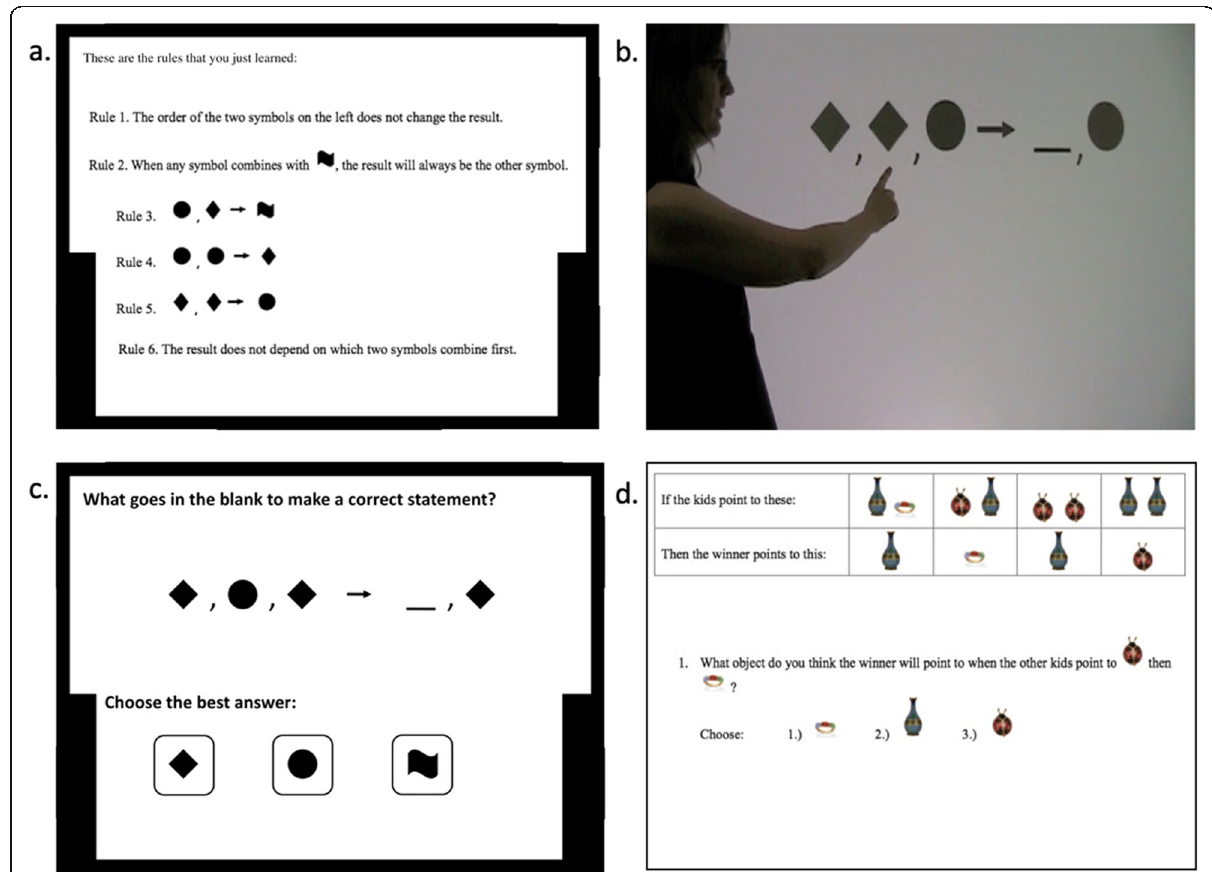
Fig. 1 Example images from the abstract mathematical task. a The summary depiction of the six rules presented to participants prior to instruction. b Screenshot from an example instructional video with gesture. c An example problem from the posttest, where the correct answer is squiggle. d An example problem from the transfer